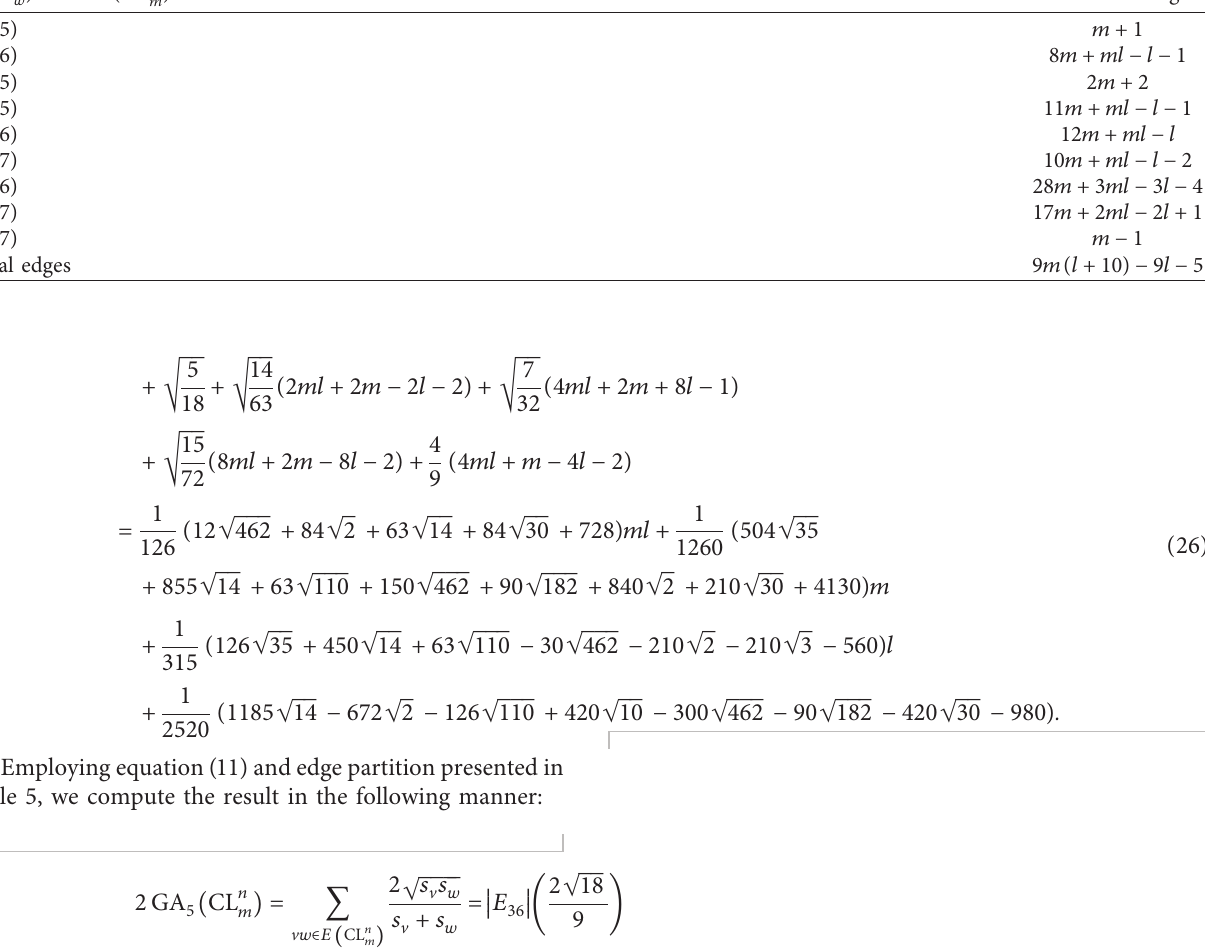
Table 5: Partitioning of the edge set with respect to neighbor’s degree sum of end vertices for GL l ( s ,s ) : vw ∈ E ( GL l v w m